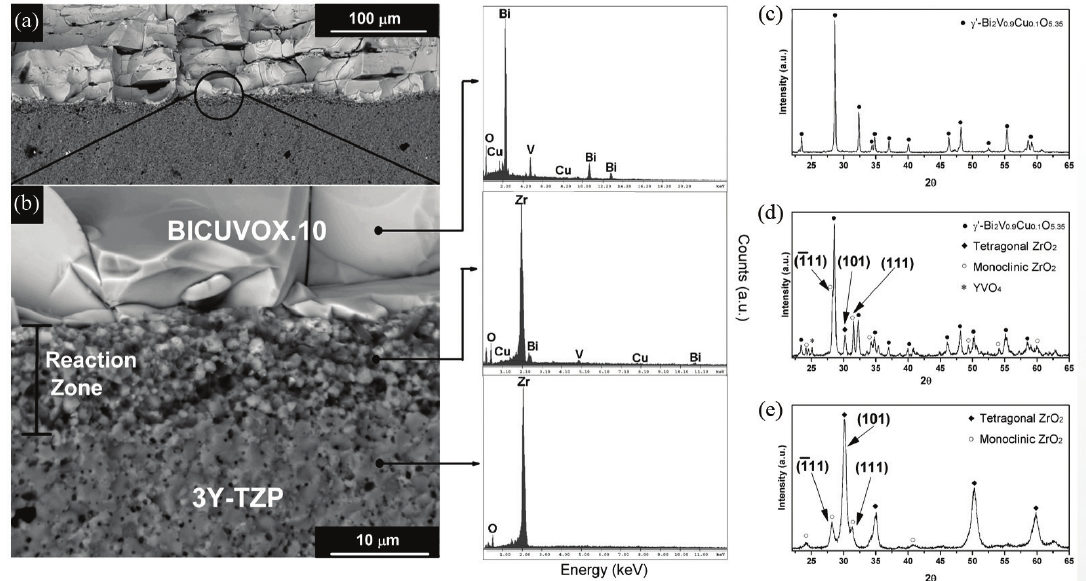
Figure 1. (a) Reaction zone created by interaction between BICUVOX.10 and 3Y-TZP. (b) Reaction zone magnification (5000x) linked to EDX analysis. X-ray diffraction patterns for (c) BICUVOX.10, (d) 50B/50Z3 and (e) 3Y-TZP. The crystallographic planes used to measure the extent of destabilization are shown in the X-ray diffraction patterns.